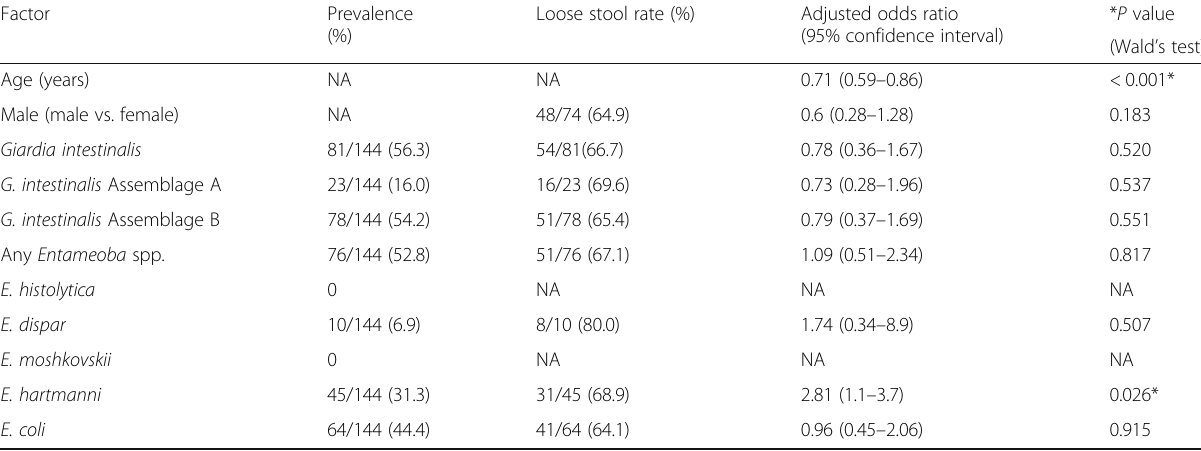
Table 1 Risk factors associated with loose stool form in healthy Indonesian children